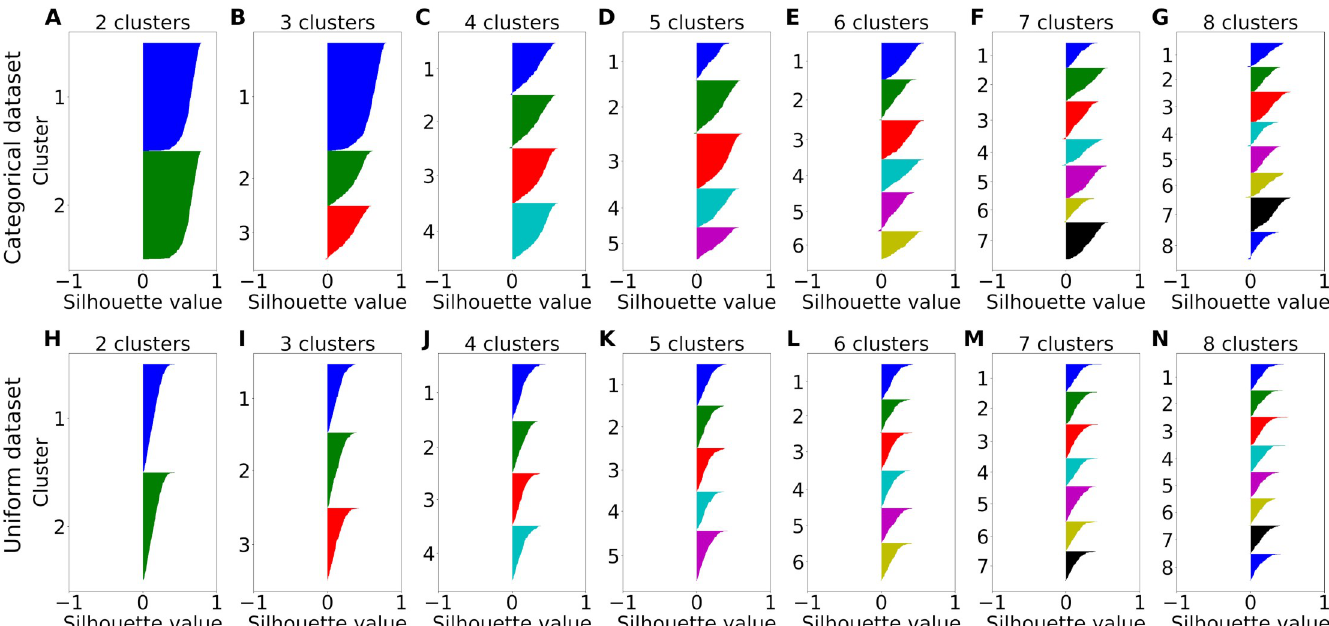
Fig 5. Silhouette comparison of spherical k-means clustering for different numbers of clusters on synthetic data. Synthetic data were either categorical (top row) simulated like in Fig 3 or non-categorical consisting of 400 samples uniformly distributed over the unit hyper-sphere (bottom row). For each data set, the number of clusters was varied between 2 and 8 (A-G) and (H-N) respectively. Each color corresponds to one cluster.